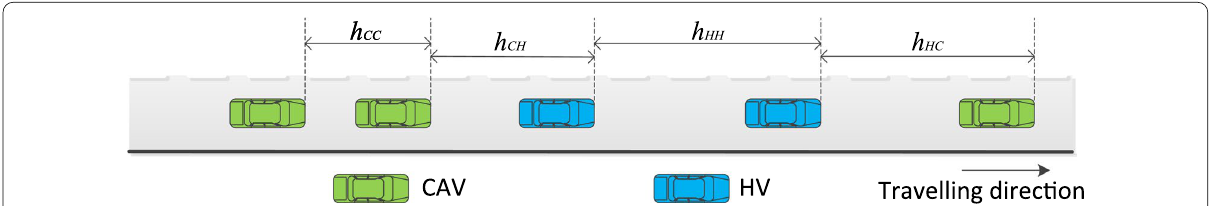
Fig. 2 Illustration of a mixed traffic flow and its headway